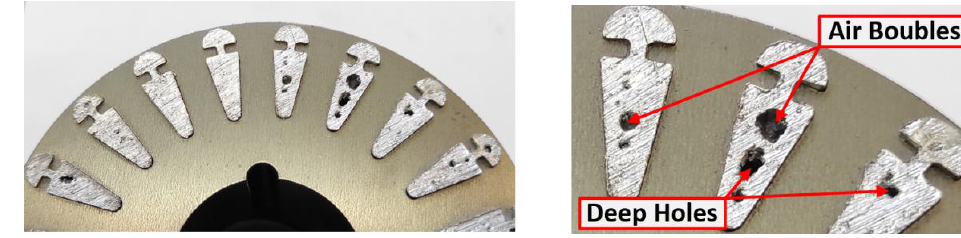
Figure 29. Cut in 1/3 of the length of the sample R3.